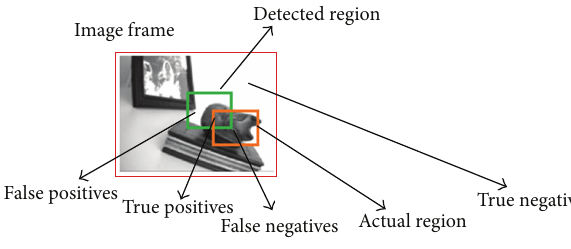
Figure 5: Illustration of frame based